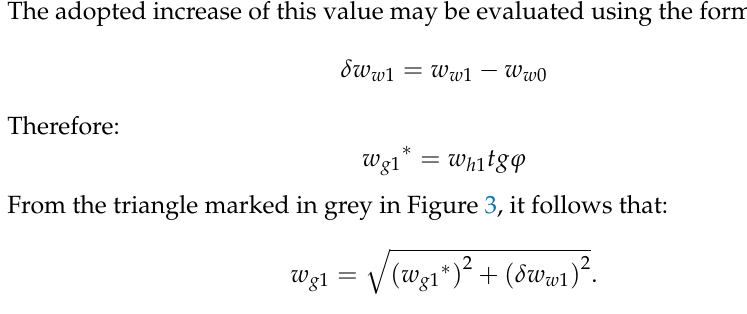
Figure 3. Vector diagram for calculating the w g value for the selected section of the route (own elaboration).